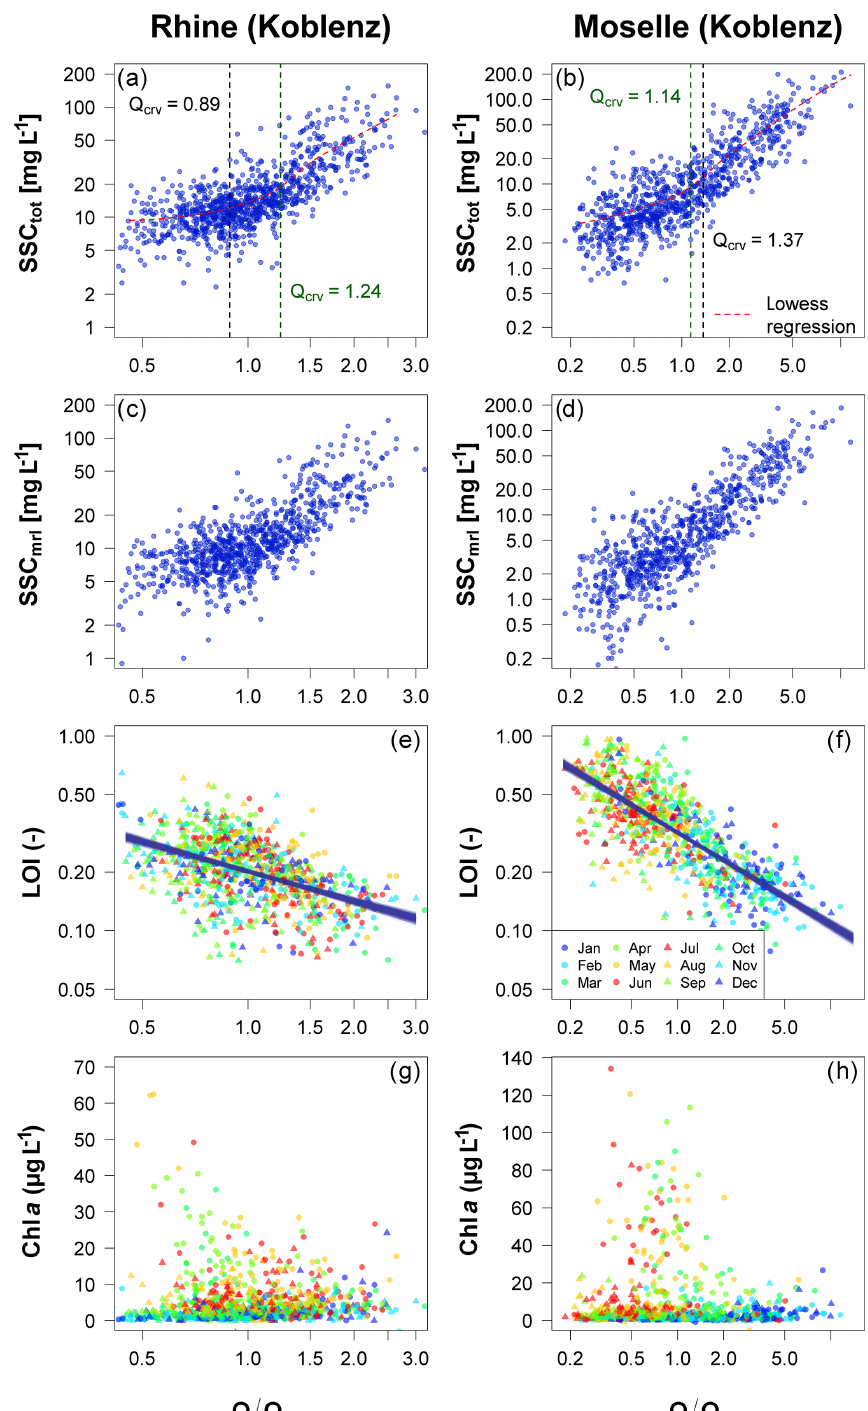
Figure 8. Rating of total SSC (a, b) , mineral SSC (c, d) , loss on ignition (LOI, e, f ), and chlorophyll a (Chl a , g, h ) for the station Koblenz Rhine (a, c, e, g) and Koblenz Moselle (b, d, f, h) . Blue lines on LOI scatterplots show regression results using 1000 bootstrap replicates.